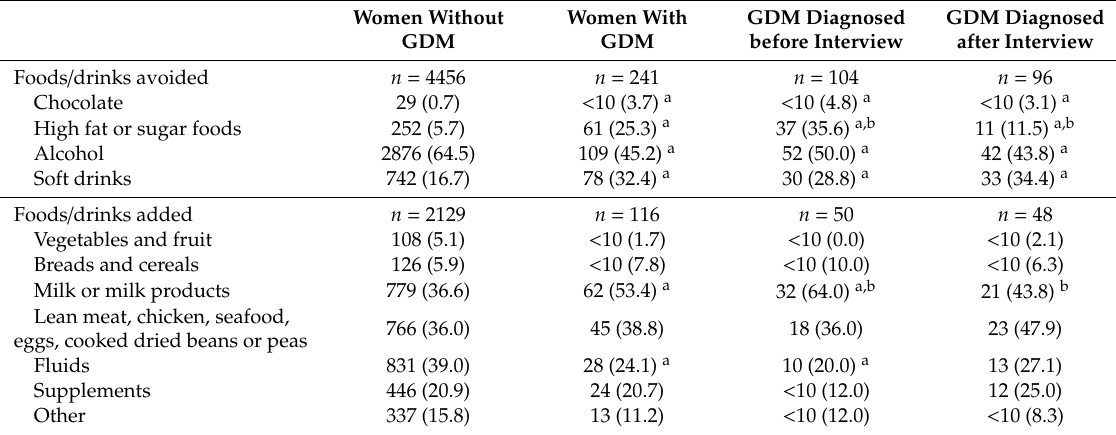
Table 5. Foods and drinks avoided or added during pregnancy.